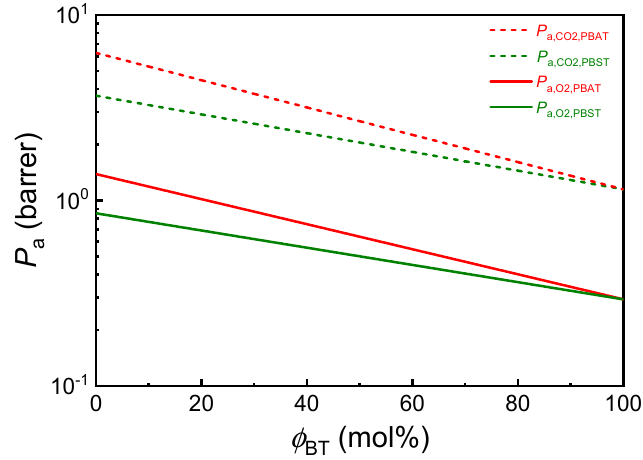
Figure 1. Predicted gas permeability coefficients ( P a , unit: barrer) of amorphous PBST and PBAT copolyesters in full composition range ( ϕ BT = 0–100 mol%). 1 barrer = 10 − 10 cm 3 ·cm·cm − 2 ·s − 1 ·cmHg − 1 = 166.8 cc·mil·10 − 2 in − 2 ·day − 1 ·atm − 1 .